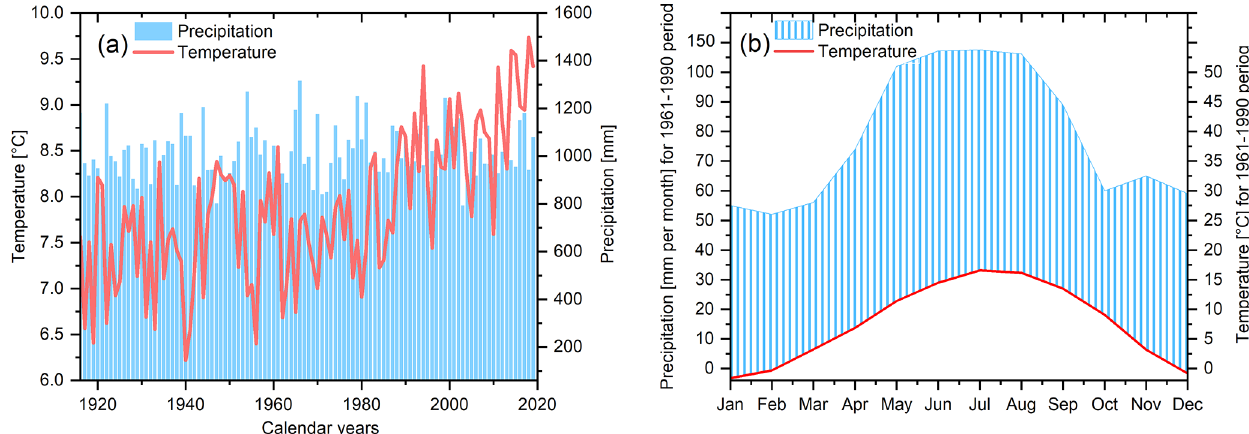
Figure 1. Climate at Hohenpeißenberg. (a) Mean annual temperatures and monthly precipitation totals since 1916, and (b) mean monthly temperatures and precipitation amounts calculated from 1961–1990 (CRU TS 4.04 data at 47.75 ◦ N/11.25 ◦